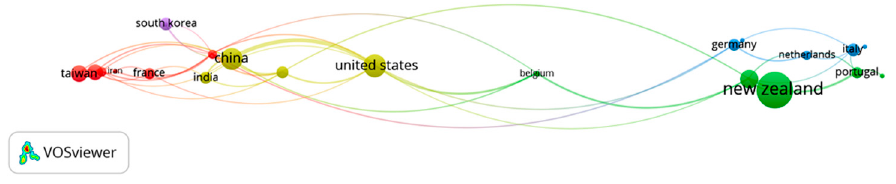
Figure 8. Impact of countries on the research domain.